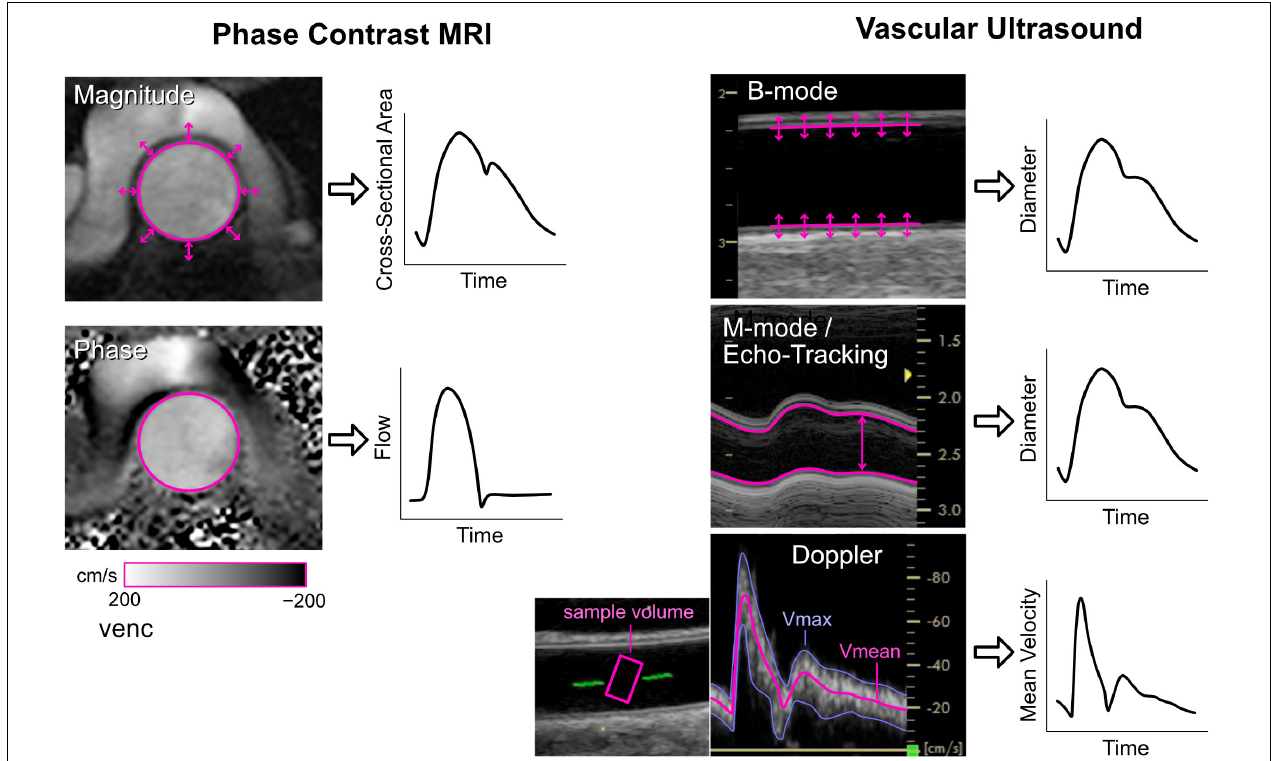
FIGURE 2 | Imaging methods for obtaining cross-sectional area or diameter waveforms and flow or mean velocity waveforms. See text for explanation. Note that echo-tracking is similar to standard M-mode but uses raw radio-frequency signals. For Doppler ultrasound, Vmax and Vmean are the maximum and mean velocities in the sample volume,